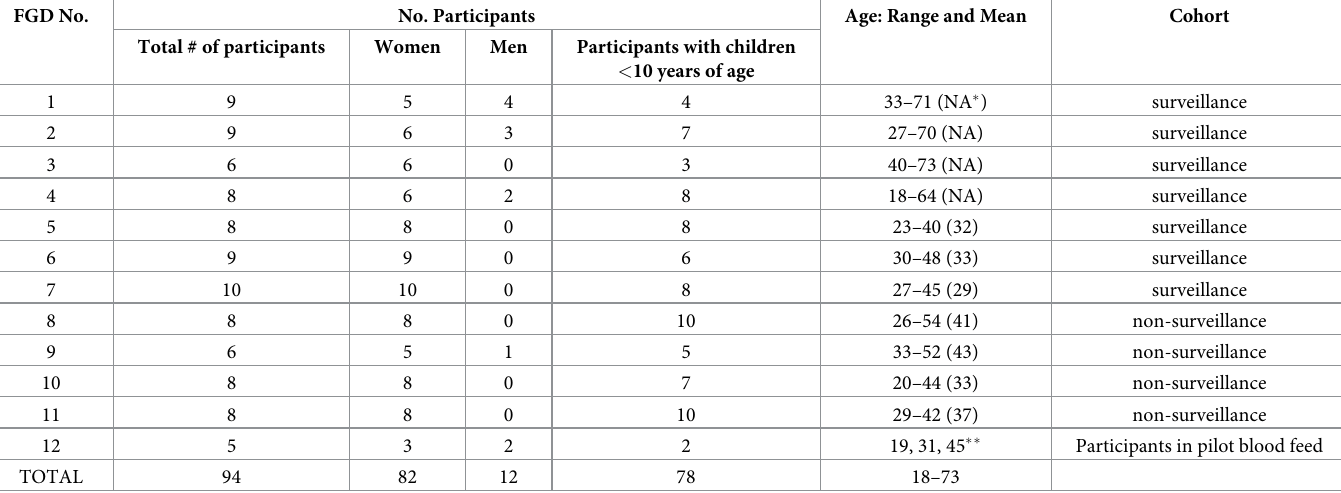
Table 1. Composition of 12 focus group discussions examining the acceptability of direct mosquito feeding experiments carried out on DENV-infected people. FGD